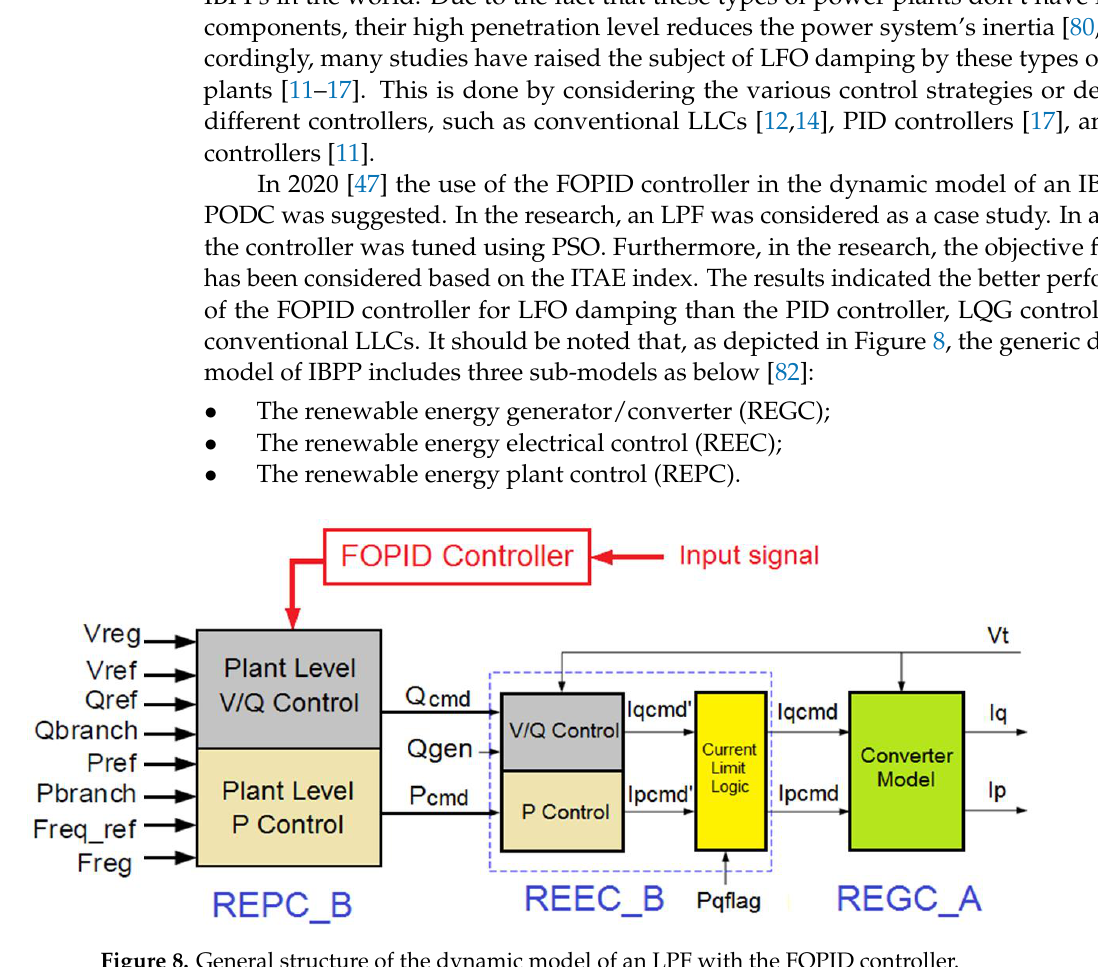
Figure 8. General structure of the dynamic model of an LPF with the FOPID controller.